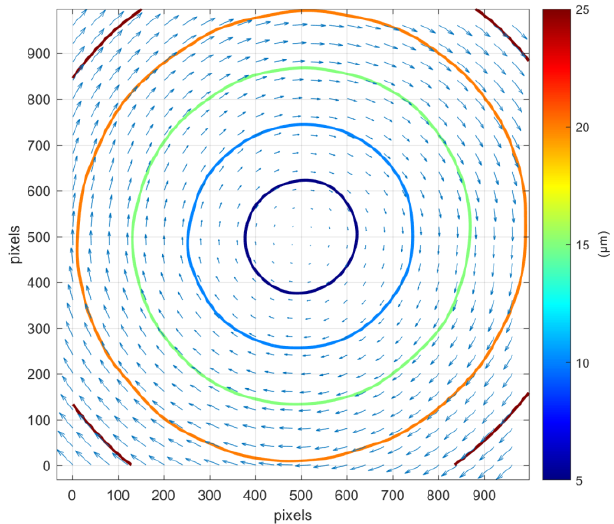
Figure 9. Synthetic in-plane displacement vectors and contours of the absolute in-plane displacement.